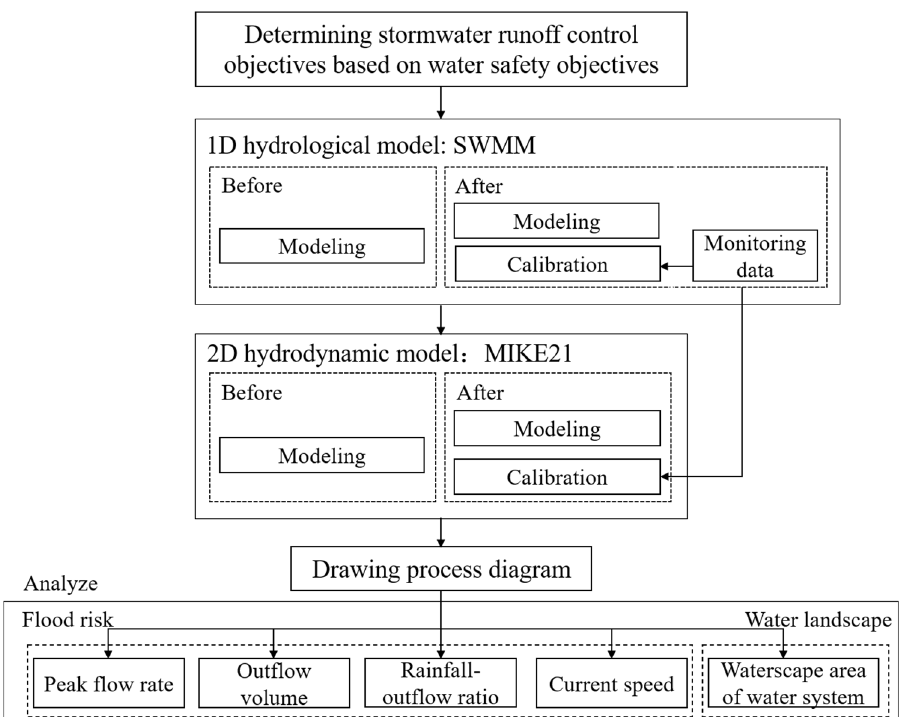
Figure 2. Research framework.